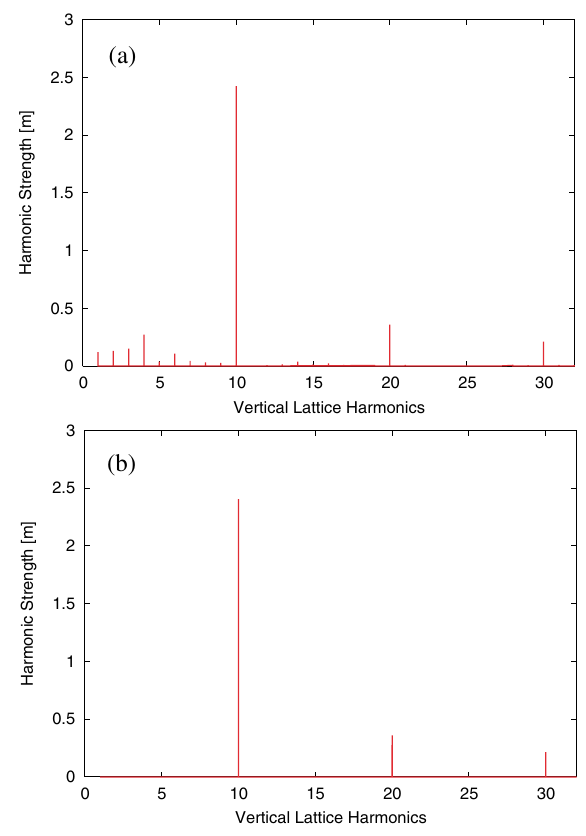
FIG. 26. (Color) Top panel: Harmonic spectrum of the vertical beta function for the real PSR lattice. Bottom panel: Harmonic spectrum of the vertical beta function for a perfectly symmet- ric, PSR-like lattice. Both lattices have (cid:3) (cid:4)